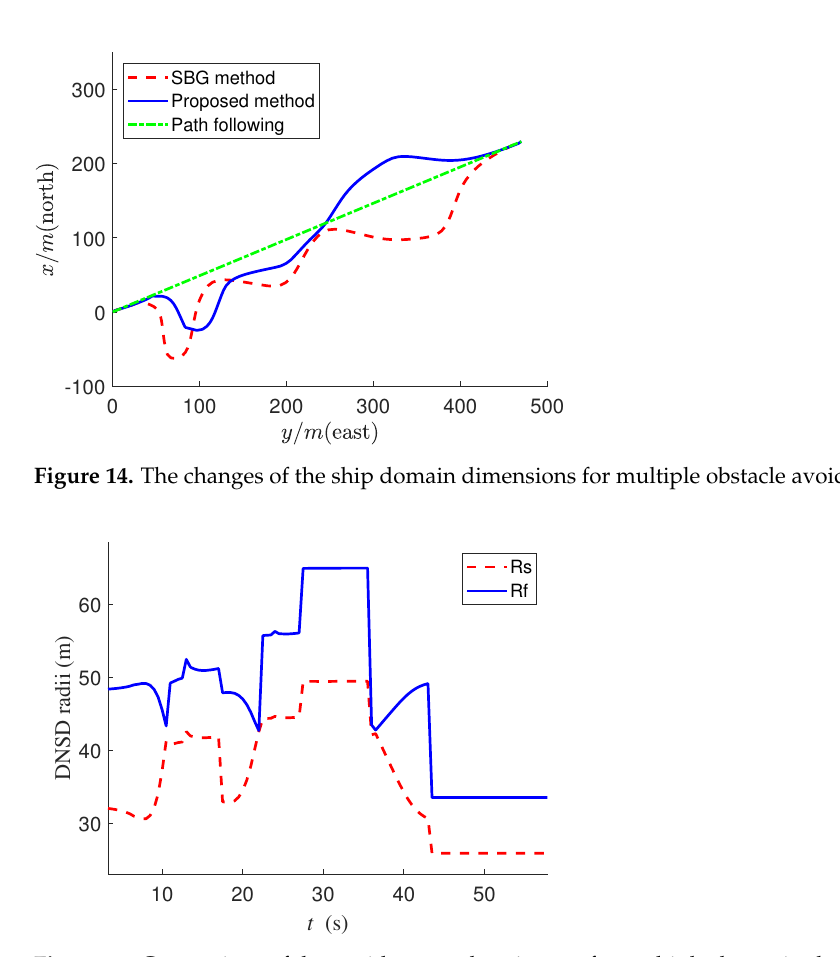
Figure 15. Comparison of the avoidance path trajectory for multiple dynamic obstacle